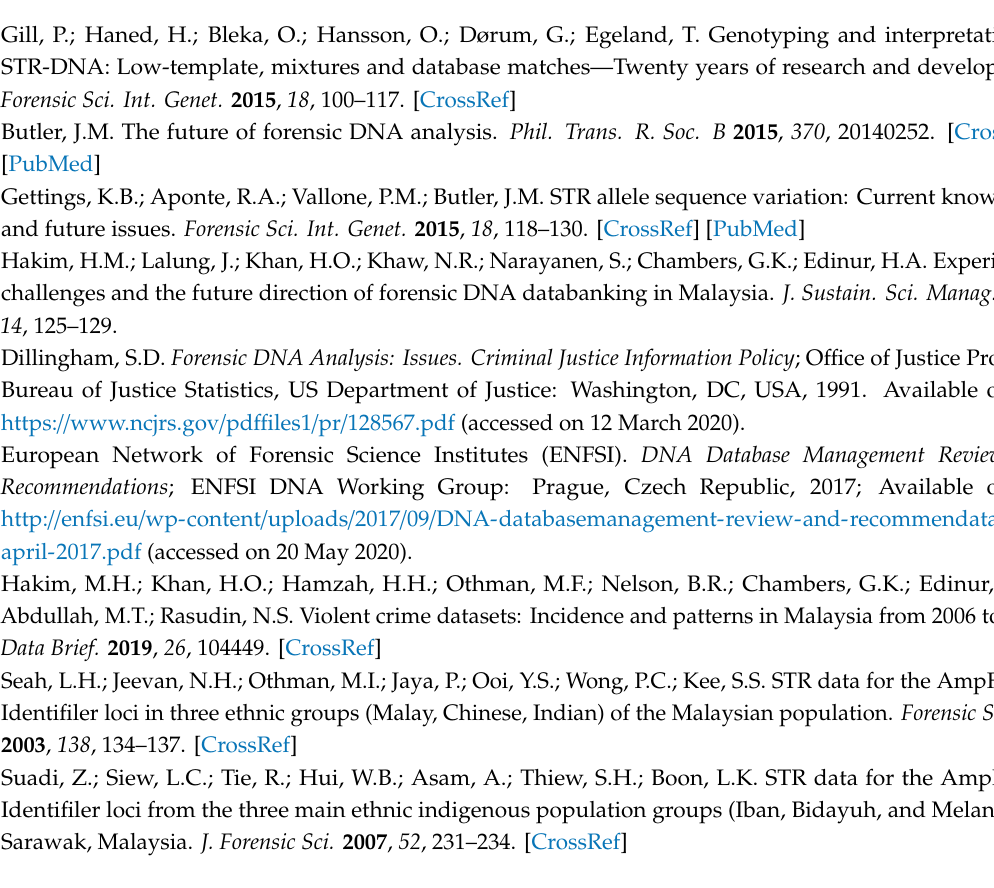
Table S1. List of hits from FDDM by type of o ff ences; Table S2. List of Y-STR studies in various population groups in Malaysia; Table S3. List of mtDNA studies in various population groups in